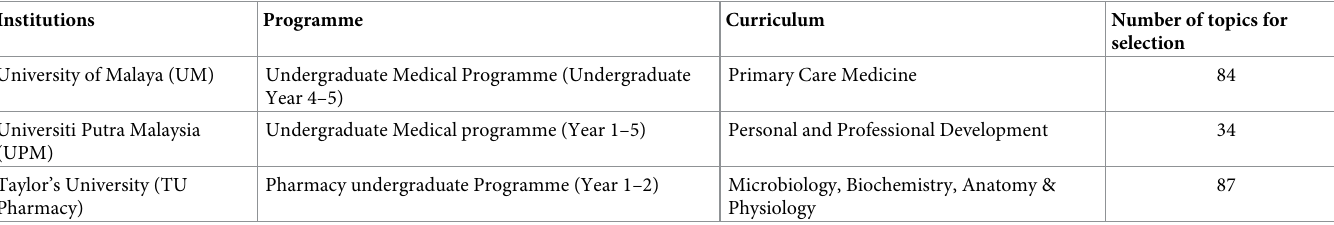
Table 1. Healthcare curricula selected for development of reusable learning objects